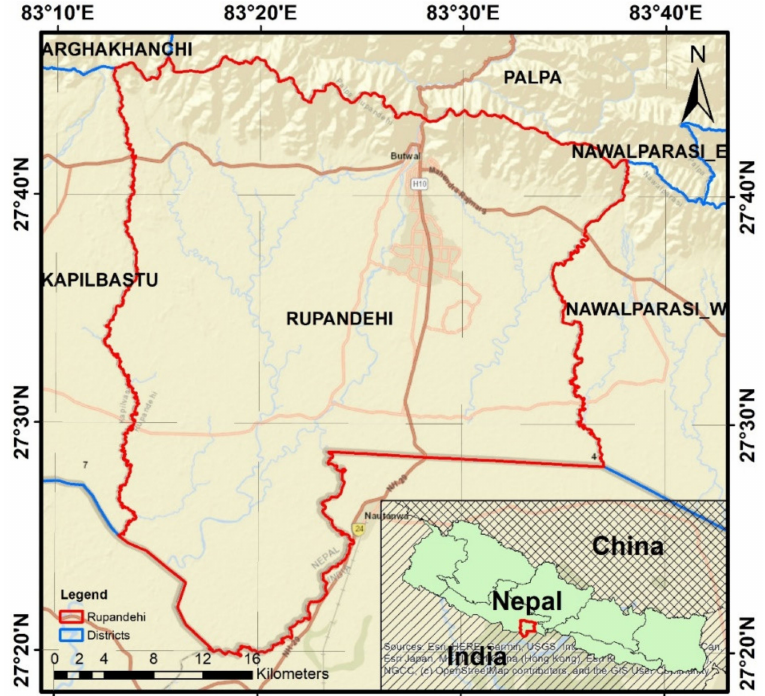
Figure 2. Location map of the study area: Rupandehi District, Nepal with ESRI’s base map.